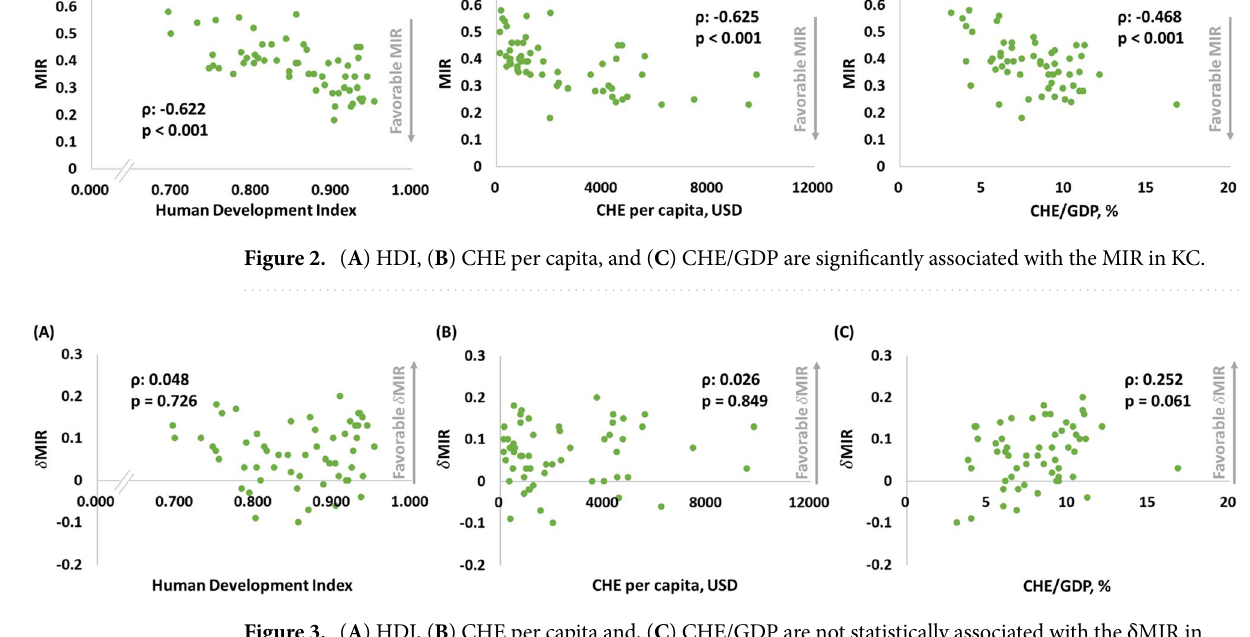
Figure 3. ( A ) HDI, ( B ) CHE per capita and, ( C ) CHE/GDP are not statistically associated with the δMIR in